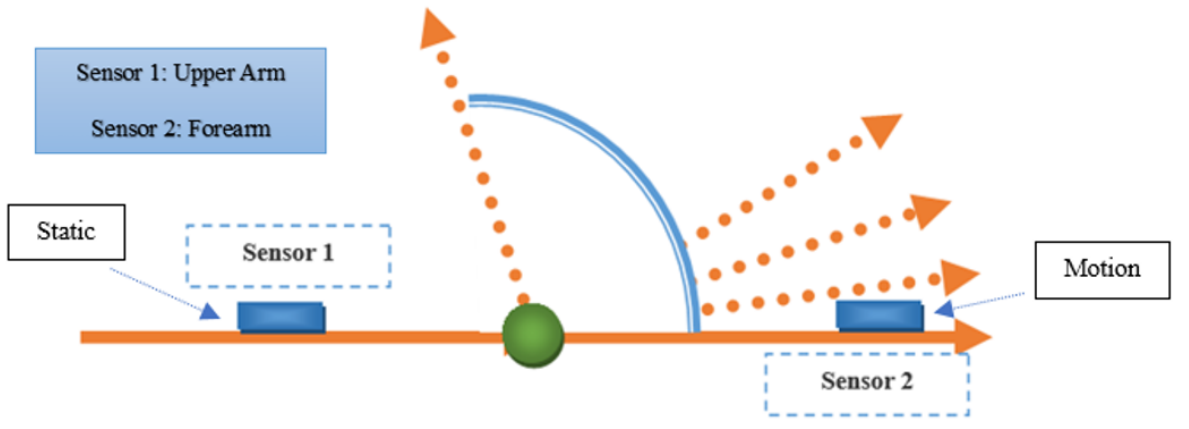
Figure 3. Joint angle (two sensors). Table 3. Angle measurement comparison (RMSE in degrees) between the proposed algorithm (PA) and WitMotion (WM).